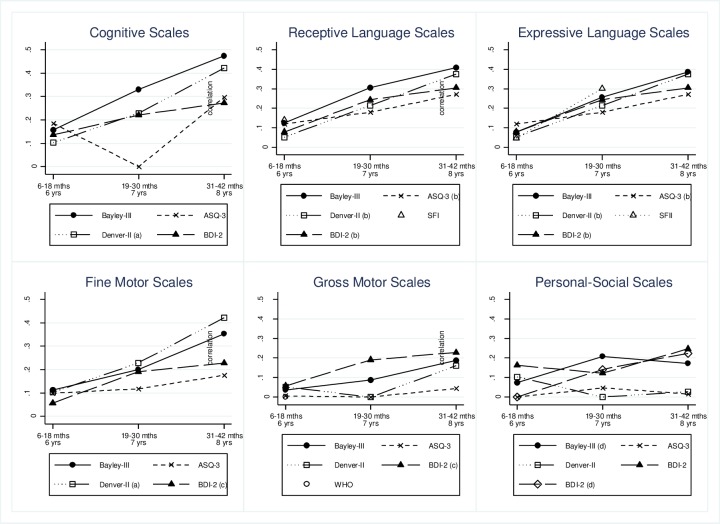
Predictive validity of Bayley-III and short tests at 6–42 months with the FSIQ at 6–8 years, by age group and domain.Each plot in Fig 2 shows, for each developmental domain, the average correlation between scores in early childhood with FSIQ scores in middle childhood, by age group. The youngest age group are children 6–18 months in early childhood and 6 years in middle childhood; the middle age group are children 19–30 months in early childhood and 7 years in middle childhood; and the oldest age group are children 31–42 months in early childhood and 8 years in middle childhood. Sample sizes for each correlation (point depicted) are in Table 2. See Fig 1 footnote for the definition of the acronyms used. aDenver-II is the fine-motor adaptive scale; bASQ-3, Denver-II and BDI-2 are the communication/language scales; cBDI-2 motor combines fine and gross motor items; dBayley-III is the socio-emotional scale; BDI-2 is the adaptive skills scale.